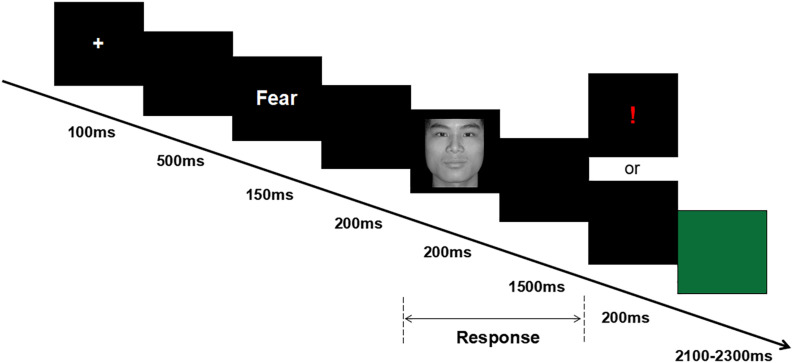
Overview of a representative experimental trial.